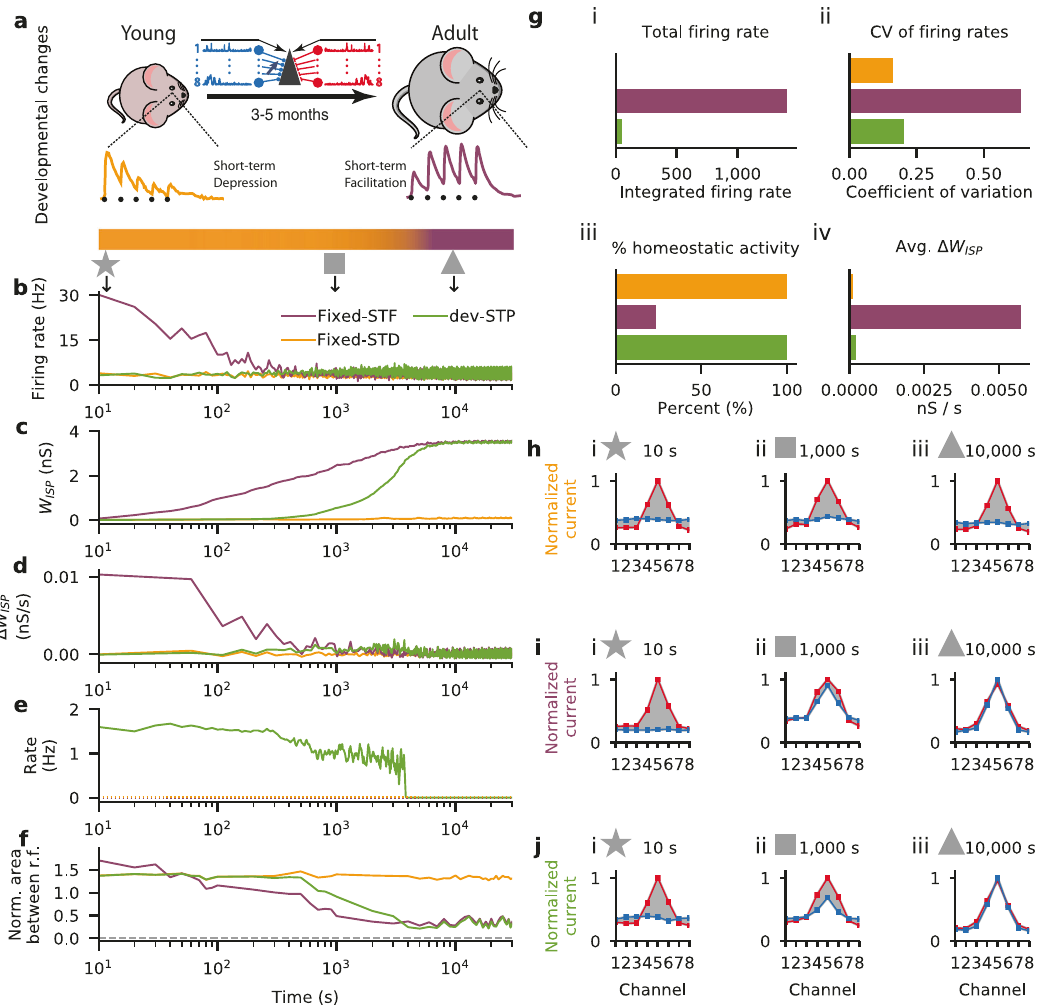
Fig. 2 Gradual short-term plasticity shift maintained stable fi ring rates while detailed E-I balance developed. a Schematic of our developmental short- term plasticity (STP) model (cf. Fig. S2); top: young and adult STP (as in Fig. 1); bottom: gradual changes in STP from depressing to facilitating dynamics (orange and purple respectively, in log-scale as in b – f ). b – f Different variables of the model across simulated development for three different models: fi xed short-term depression ( fi xed-STD, orange), fi xed short-term facilitation ( fi xed-STF, purple) and developmental model with gradual changes in STP (dev- STP, green line). Note x -axis on log-scale. b Receiver neuron fi ring rate. c Mean inhibitory weight. d Mean changes in the weight of the inhibitory synaptic afferents. e Rate of STP change (note that the curves for both fi xed-STF and fi xed-STD remain fi xed at 0 as these models do not consider any developmental changes to STP, shown as dashed lines). f Area between normalized excitatory and inhibitory tuning curves (cf. h – j ) during the course of simulated development. A normalized area close to 0 represents a perfectly balanced neuron. g Additional statistics for the three models. (i) Total neuronal activity calculated using the area between the fi ring rate in b and the desired target rate of 5 Hz. (ii) Average coef fi cient of variation of the fi ring rates across simulated development (cf. b ). (iii) Percent of time spent under homeostasis (i.e., at the desired fi ring rate; cf. b ). (iv) Average change in inhibitory weights (cf. d ). h – j Snapshots of excitatory and inhibitory tuning curves across three points in simulated development: 10 s (star), 1000s (square) and 10,000s (triangle). Shaded gray area represents difference between excitatory and inhibitory tuning curves (cf. f ). h – j Excitatory (red) and inhibitory (blue) postsynaptic tuning curves for the fi xed-STD ( h ), fi xed-STF ( i ) and dev-STP models ( j